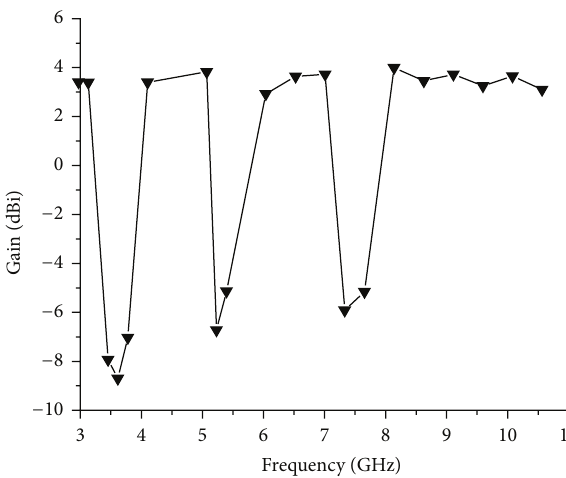
Figure 12: Measured maximum gain of the proposed antenna.